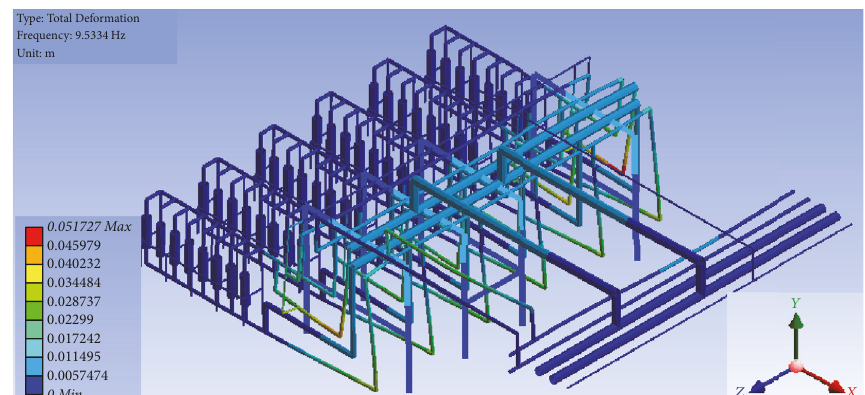
Figure 10: Vibration mode of the 5th modal order.